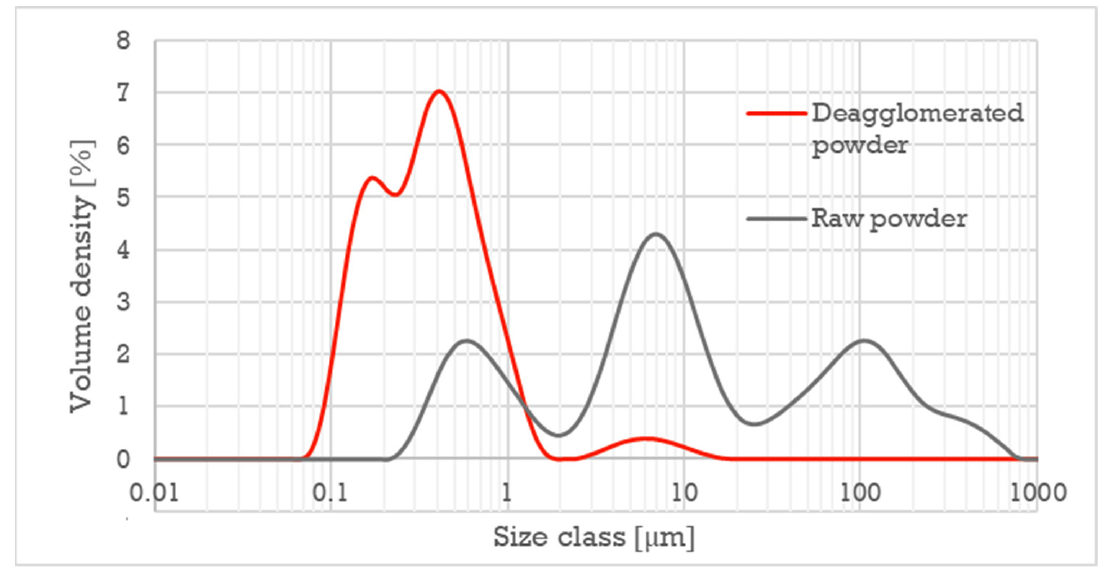
Figure 5. Particle size distribution of the raw CT 3000 LS SG alumina powder.